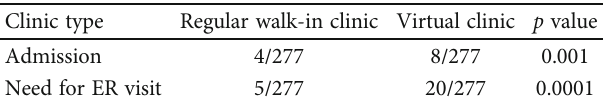
Table 4: Admission and need for ER visits in virtual vs. regular